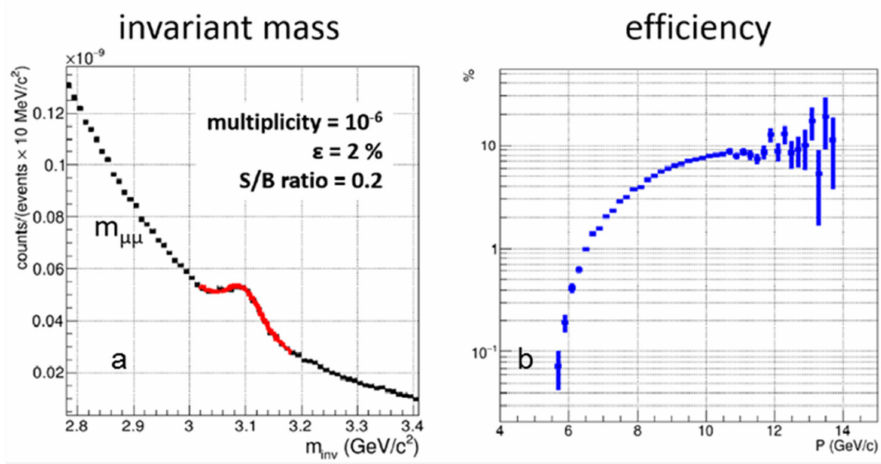
Figure 10. Dimuon invariant mass spectrum calculated for central Au + Au collisions at 8A GeV/c ( a ) [54]. The background was generated using the UrQMD code, the J/ ψ multiplicity was taken from [46]. J/ ψ reconstruction efficiency as function of momentum ( b